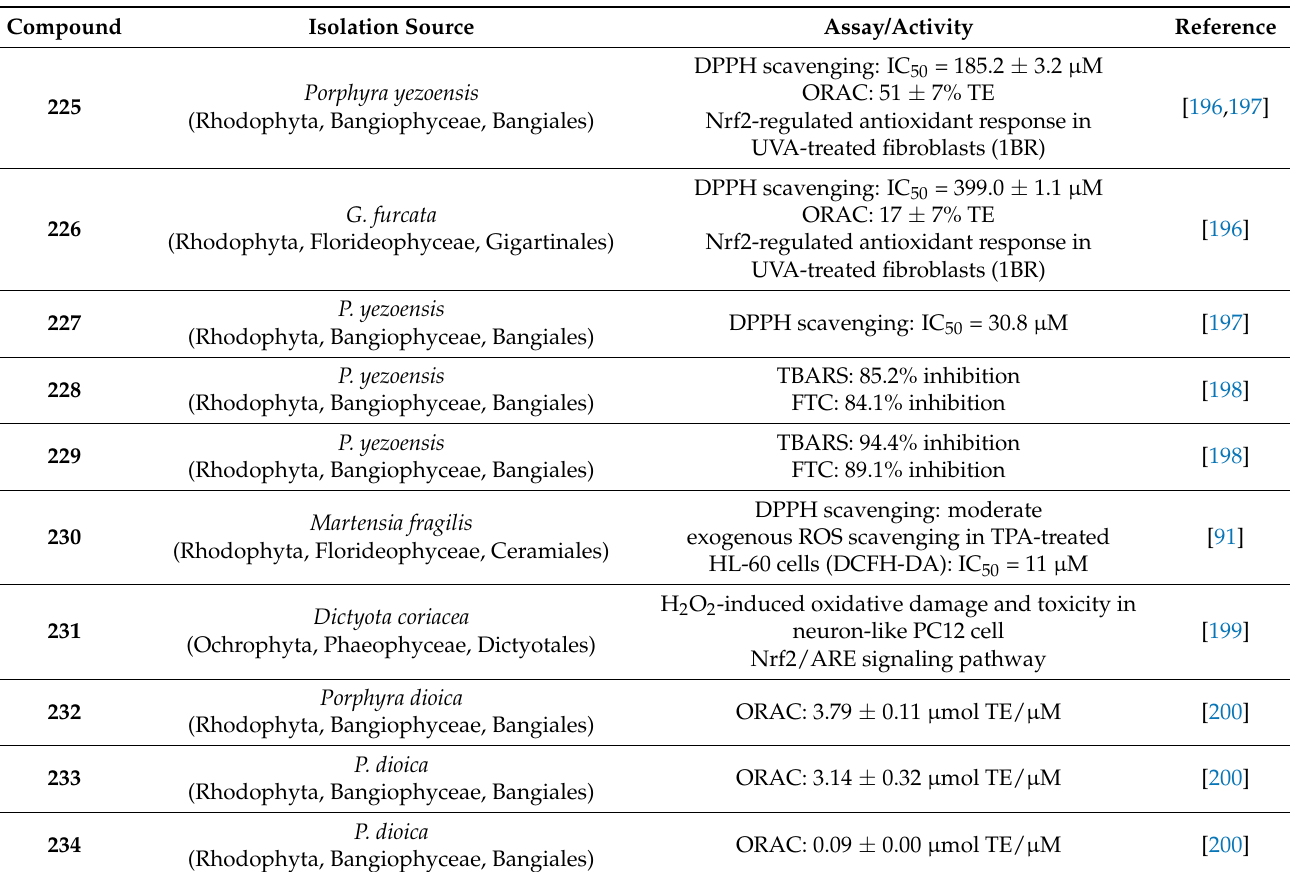
Table 5. Nitrogenous compounds from macroalgae with antioxidant